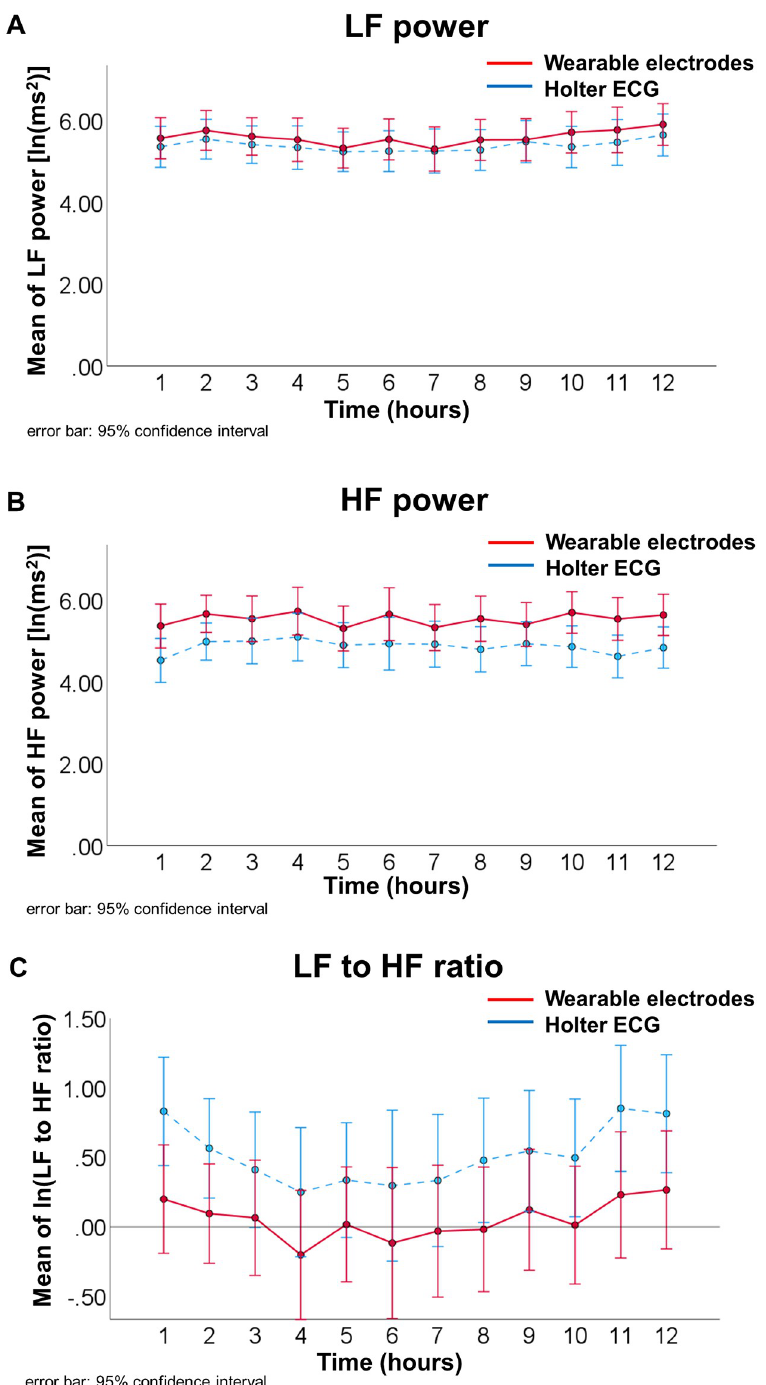
Fig 5. The frequency-domain analysis of heart rate variability analyzed every hour between wearable electrodes embedded in undershirts and Holter ECG. (A) LF power, (B) HF power and (C) LF to HF ratio. Abbreviations: LF, low-frequency; HF, high-frequency; ln, natural logarithm; ECG, electrocardiogram.